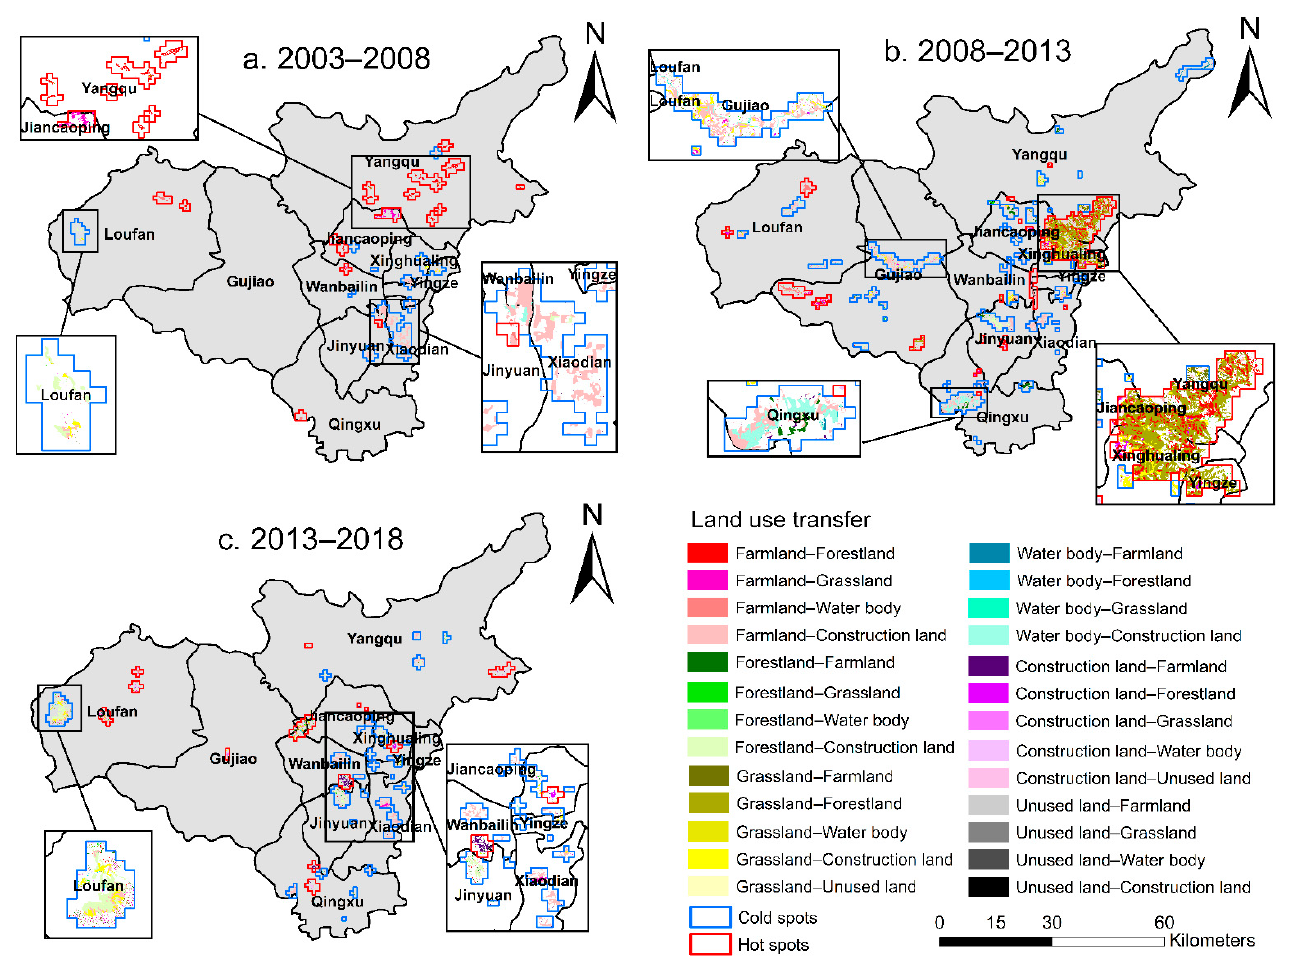
Figure 7. The transition between land use types and the spatial distribution of ESV cold spots and hot spots in Taiyuan City.